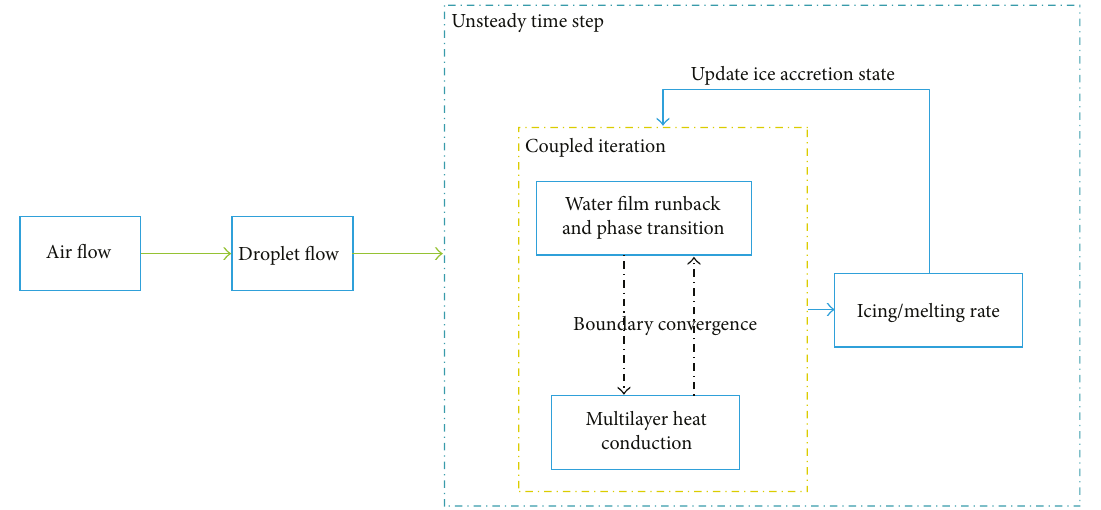
Figure 2: Diagram of coupling solution